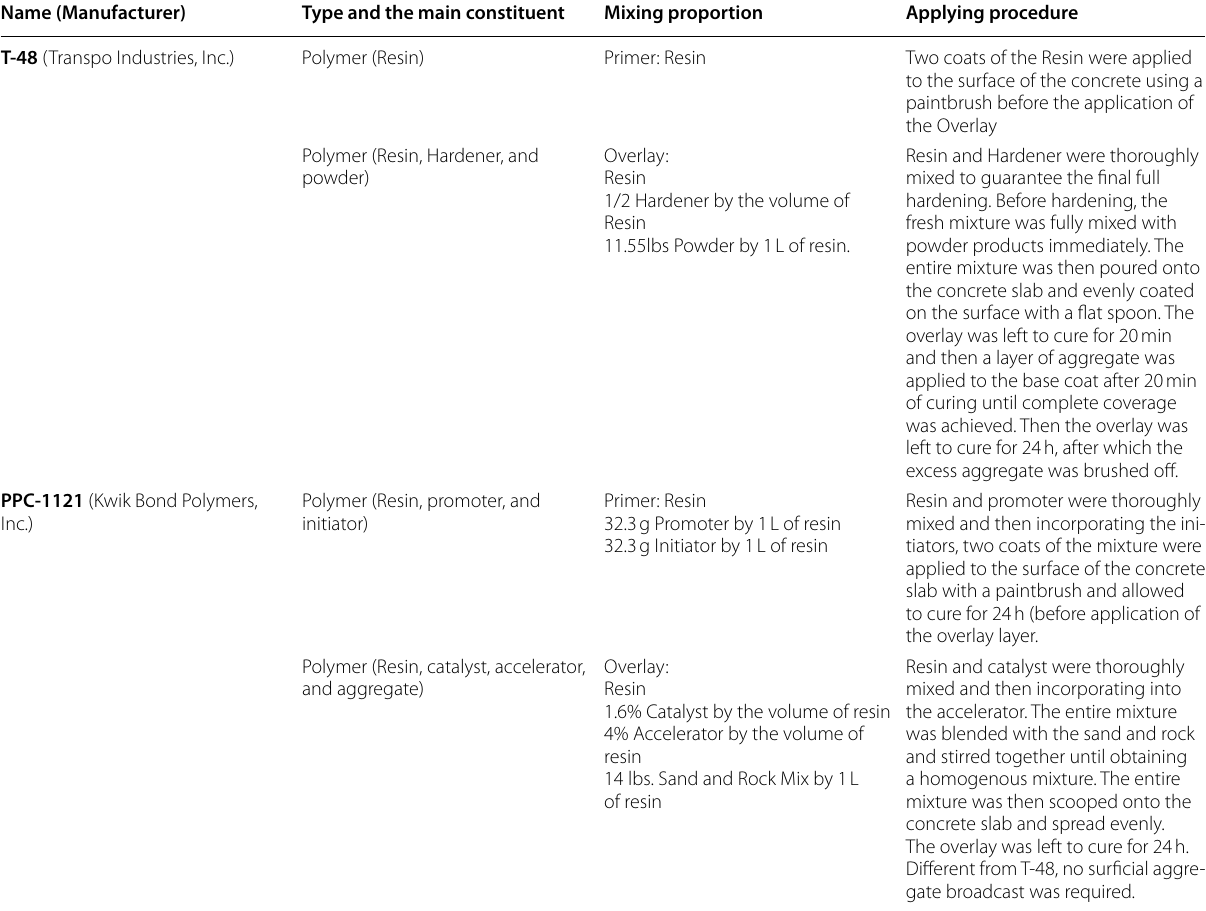
Table 4 Mixing proportioning and procedure of polymer overlays Name (Manufacturer) Type and the main constituent T-48 (Transpo Industries,